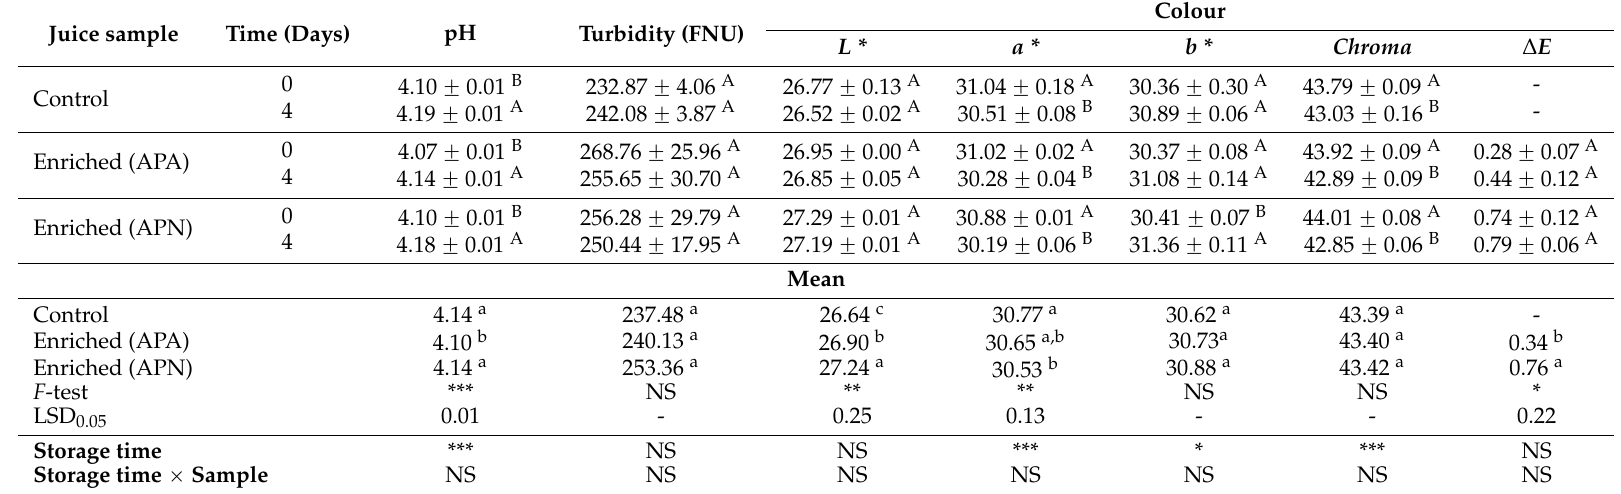
Table 2. Quality markers of tomato juice with added phenolic extracts compared to control before ( t 0 ) and after storage ( t 4 ).